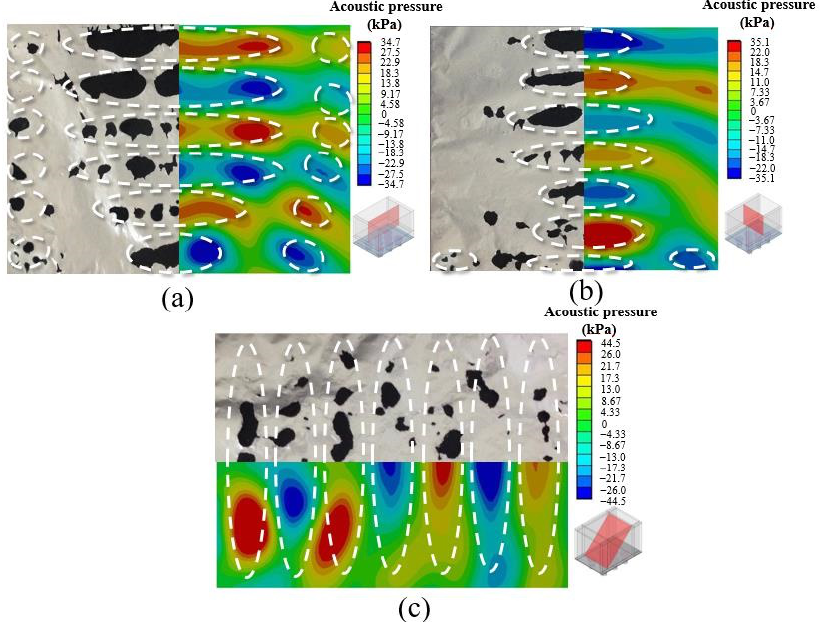
Figure 5. Acoustic pressure distribution from the TDA in some areas compared to the results from foil corrosion test. ( a ) lengthwise, ( b ) crosswise, and ( c ) oblique, along the bottom base.